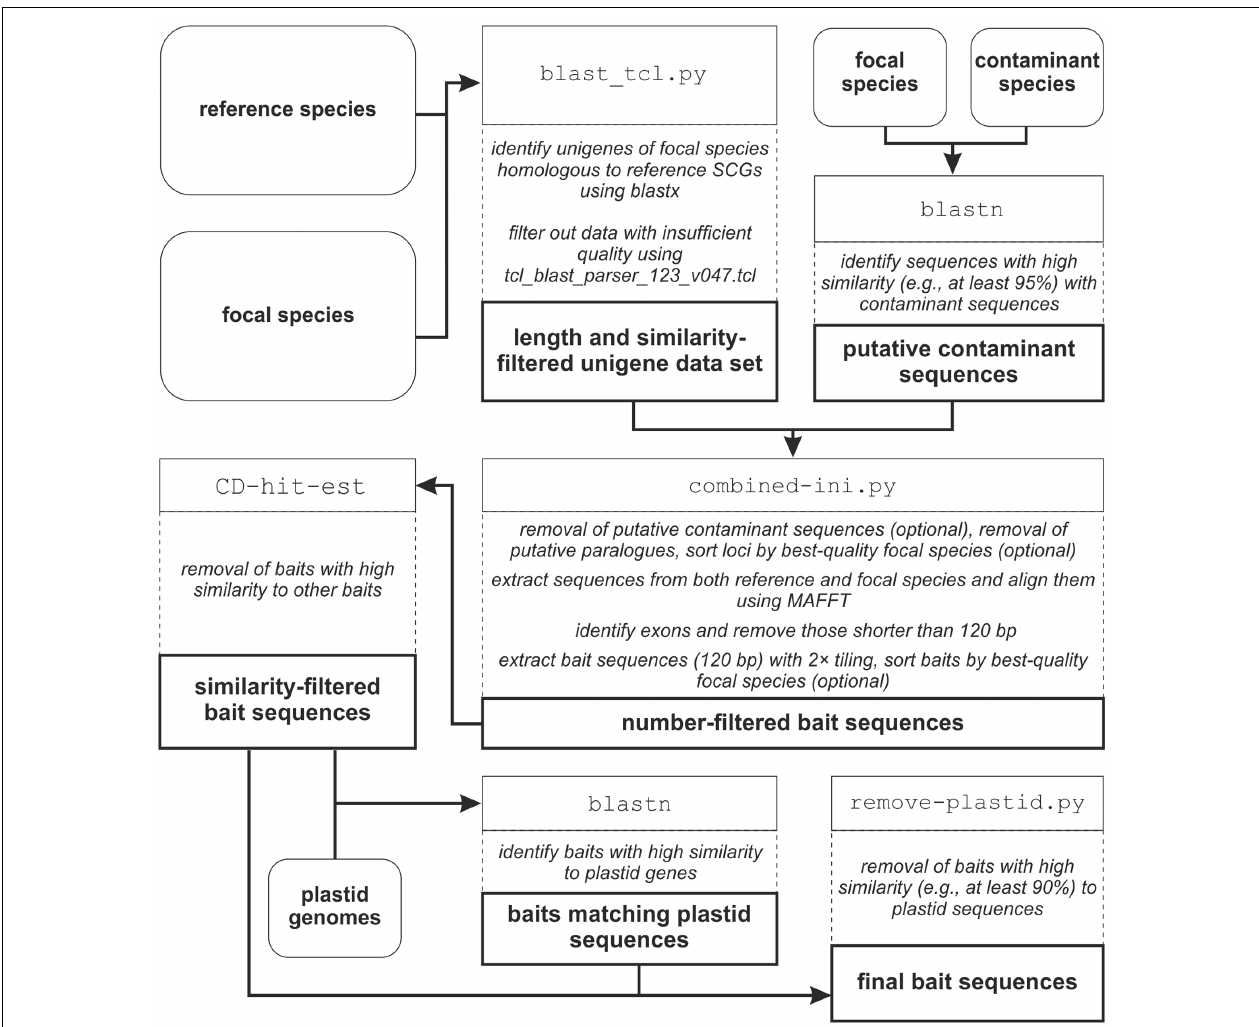
FIGURE 1 | Workflow of the pipeline. External data are indicated by rounded boxes, data generated within the pipeline by thick-outlined boxes; programs and/or scripts are indicated by Courier New font in thin-outlined boxes; the rationale of each step is given in dashed out-lined